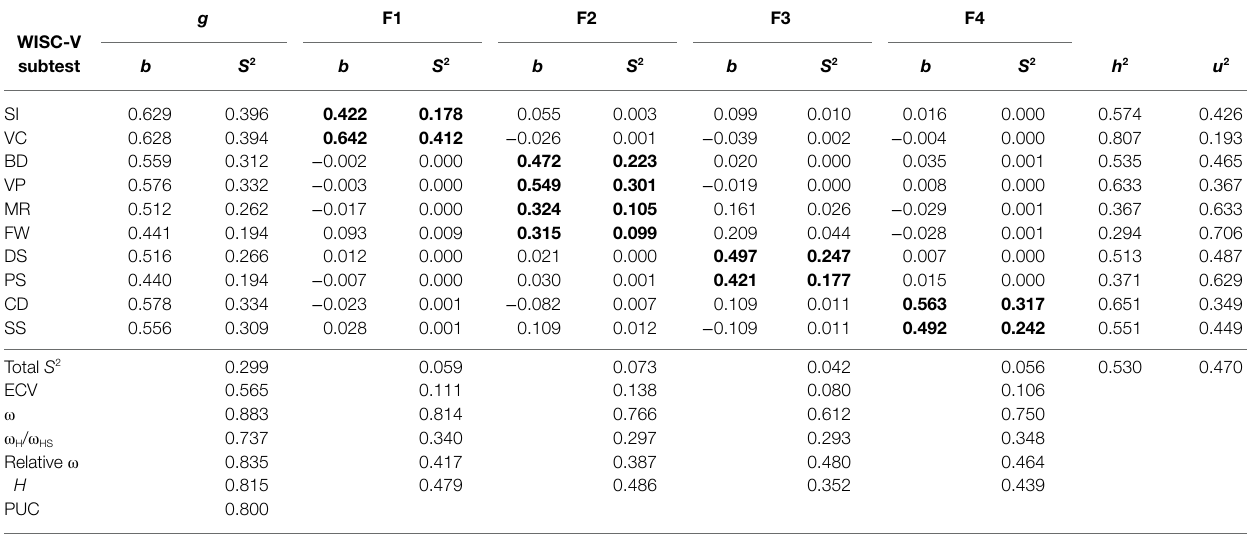
TABLE 5 | Sources of variance in the 10 WISC-V primary subtests for the EFA sample ( n = 823) according to a SL-orthogonalized higher-order factor model with four first-order factors. g WISC-V subtest